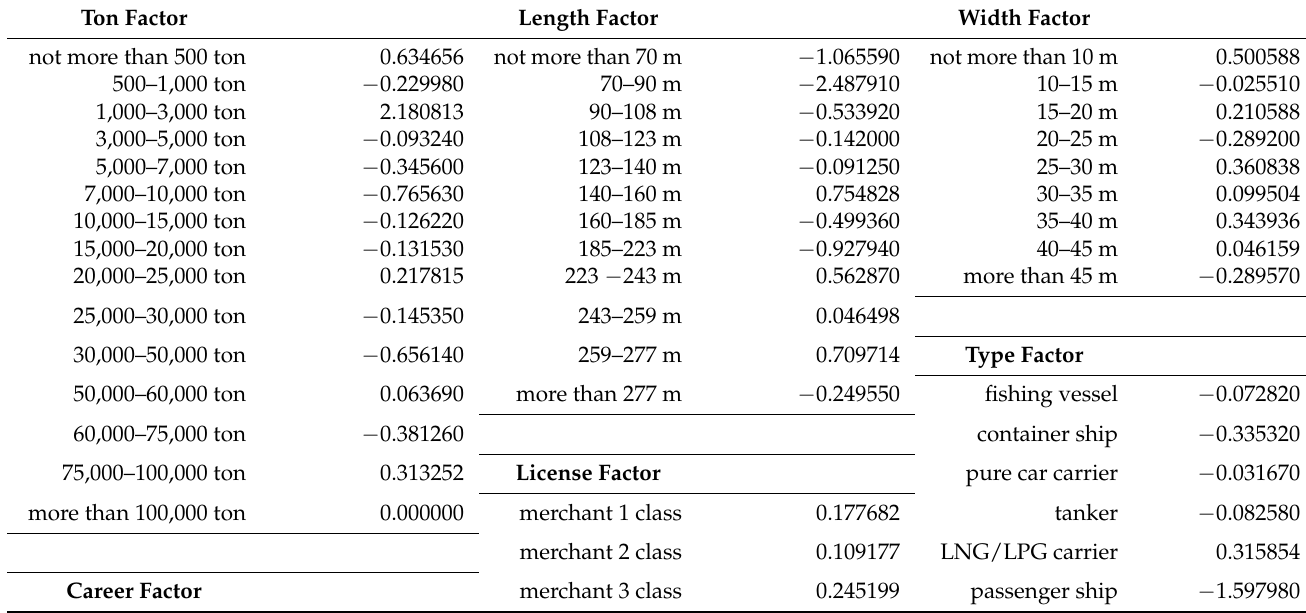
Table A1. Factor values indicating the effect of each element the marine traffic safety of a ship in the PARK Model. Ton Factor Length Factor Width